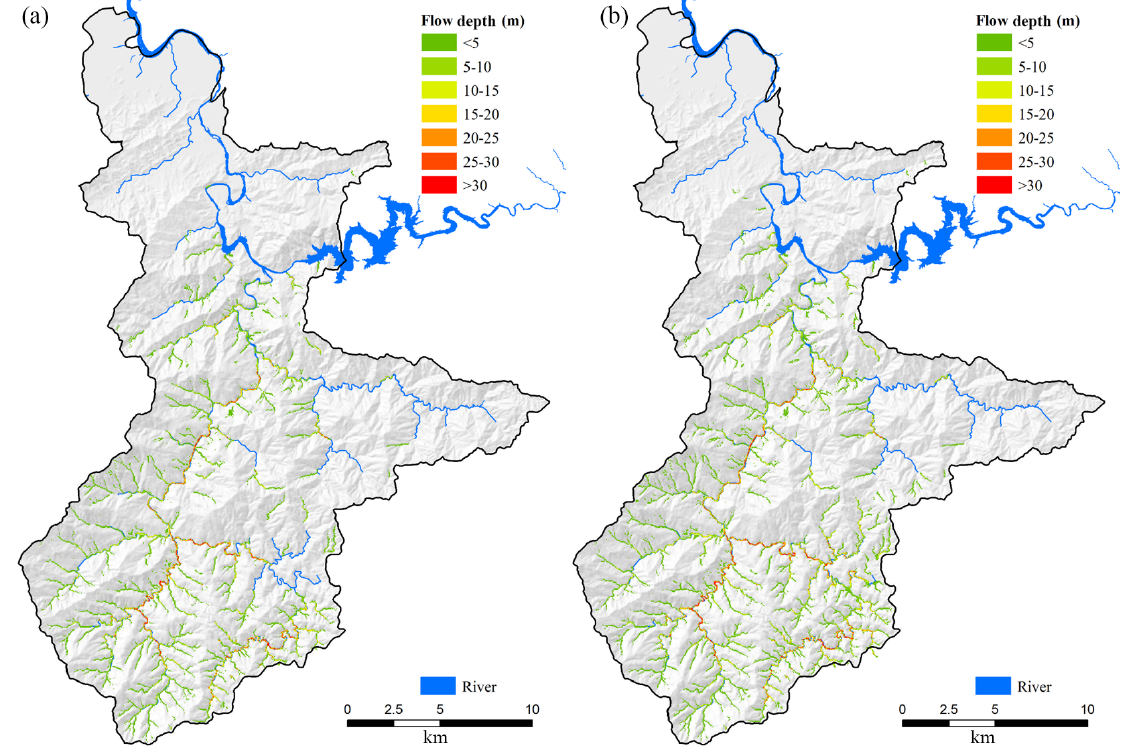
Figure 9. Final flow depth of debris flow simulated by DEBRIS-2D ( a : scenario 1, b : scenario 2).